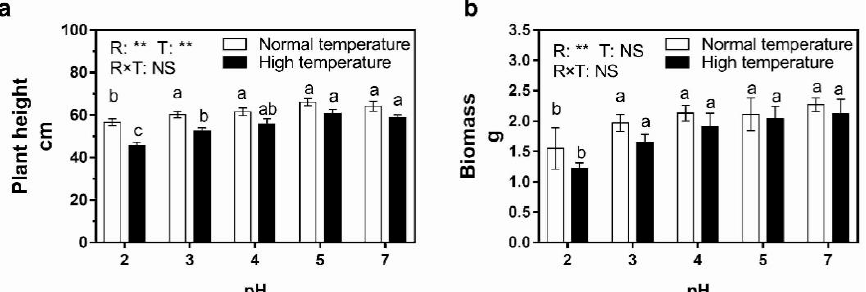
Figure 1. Effect of 7-day simulated acid rain treatment on the growth of rice plants under normal- and high-temperature conditions. ( a ) Plant height. ( b ) Biomass. The columns with the same letter in each panel indicate an insignificant difference among different treatments ( p < 0.05). The p values of two-way ANOVA for rain pH (R), temperature (T) and their interaction (R × T) are shown: **, p ≤ 0.01, NS, p > 0.05.